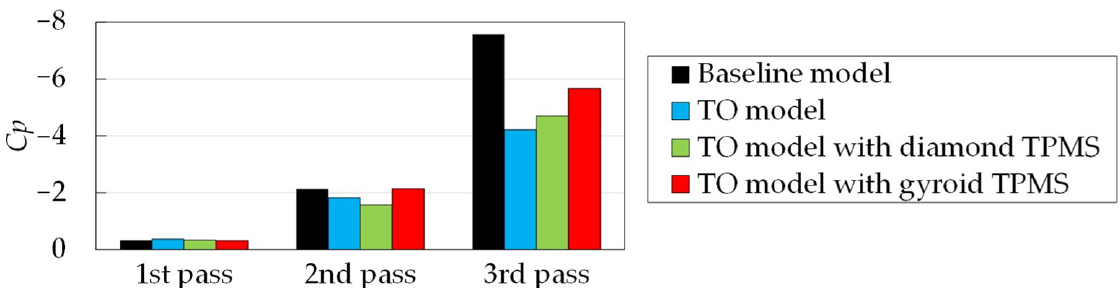
Figure 13. Comparisons of relative pressure coefficient for all serpentine channels at Re = 10,000.